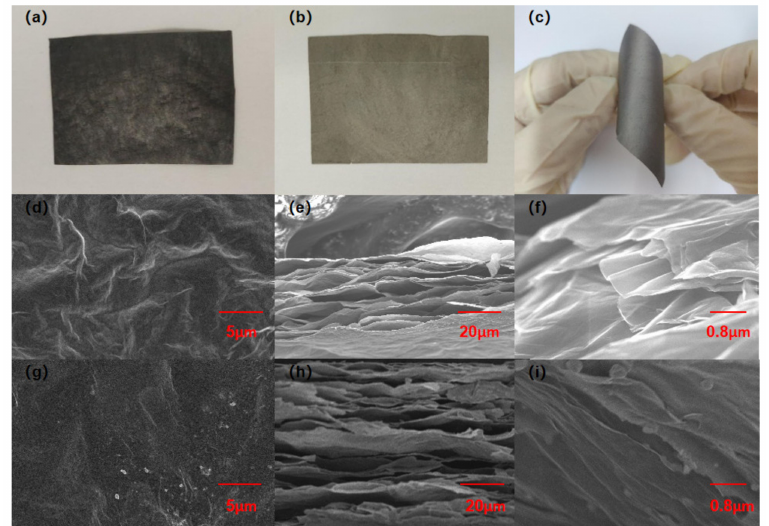
Figure 2. ( a ) Optical diagram of GO-Ni-HPMC-15 film; ( b ) Optical diagram of RGO-Ni-HPMC-15 composite film; ( c ) RGO-Ni-HPMC-15 composite film bending folding optical diagram; ( d ) Sur- face microstructure of RGO film; ( e , f ) RGO film cross section microstructure diagram; ( g ) Surface microstructure of RGO-Ni-HPMC-15 composite membrane; ( h , i ) RGO-Ni-HPMC-15 composite membrane cross section microstructure